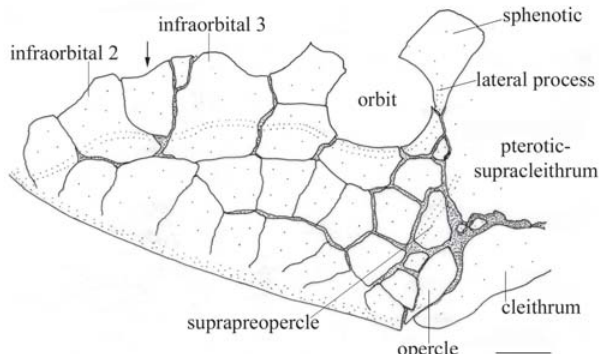
Fig. 36. Lateral view of region of snout and orbit (left side) of Lamontichthys avacanoeiro (MNRJ 18553, 98.1 mm SL, paratype). Arrow points to plate between infraorbitals 2 and 3. Scale bar = 2 mm.